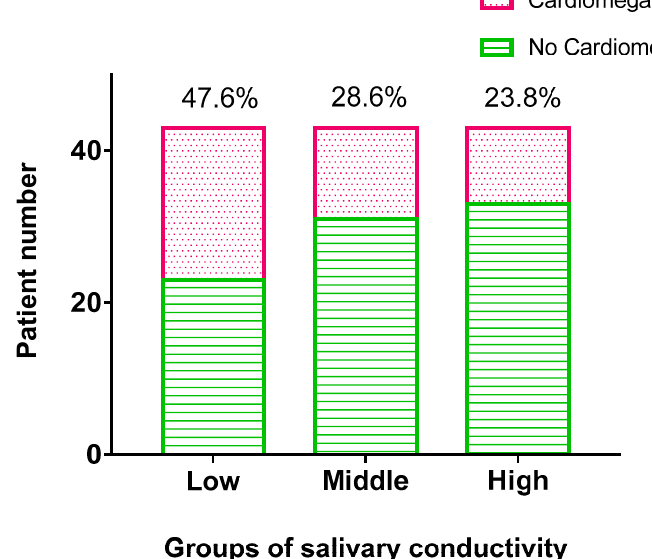
Figure 3. Distribution of cardiomegaly from low to high salivary conductivity groups. Patients were divided into low, middle, and high salivary conductivity groups according to the tertials of conduc- tivity levels (range values: Low ≤ 6273.23 μ s/cm; 6273.23 < Middle ≤ 8131.59 μ s/cm; High > 8131.59 μ s/cm). The number and percentage of patients with cardiomegaly were demonstrated in the bar chart (Chi-square = 5.296, p for trend: 0.021 *). Note: * p ≤ 0.05.